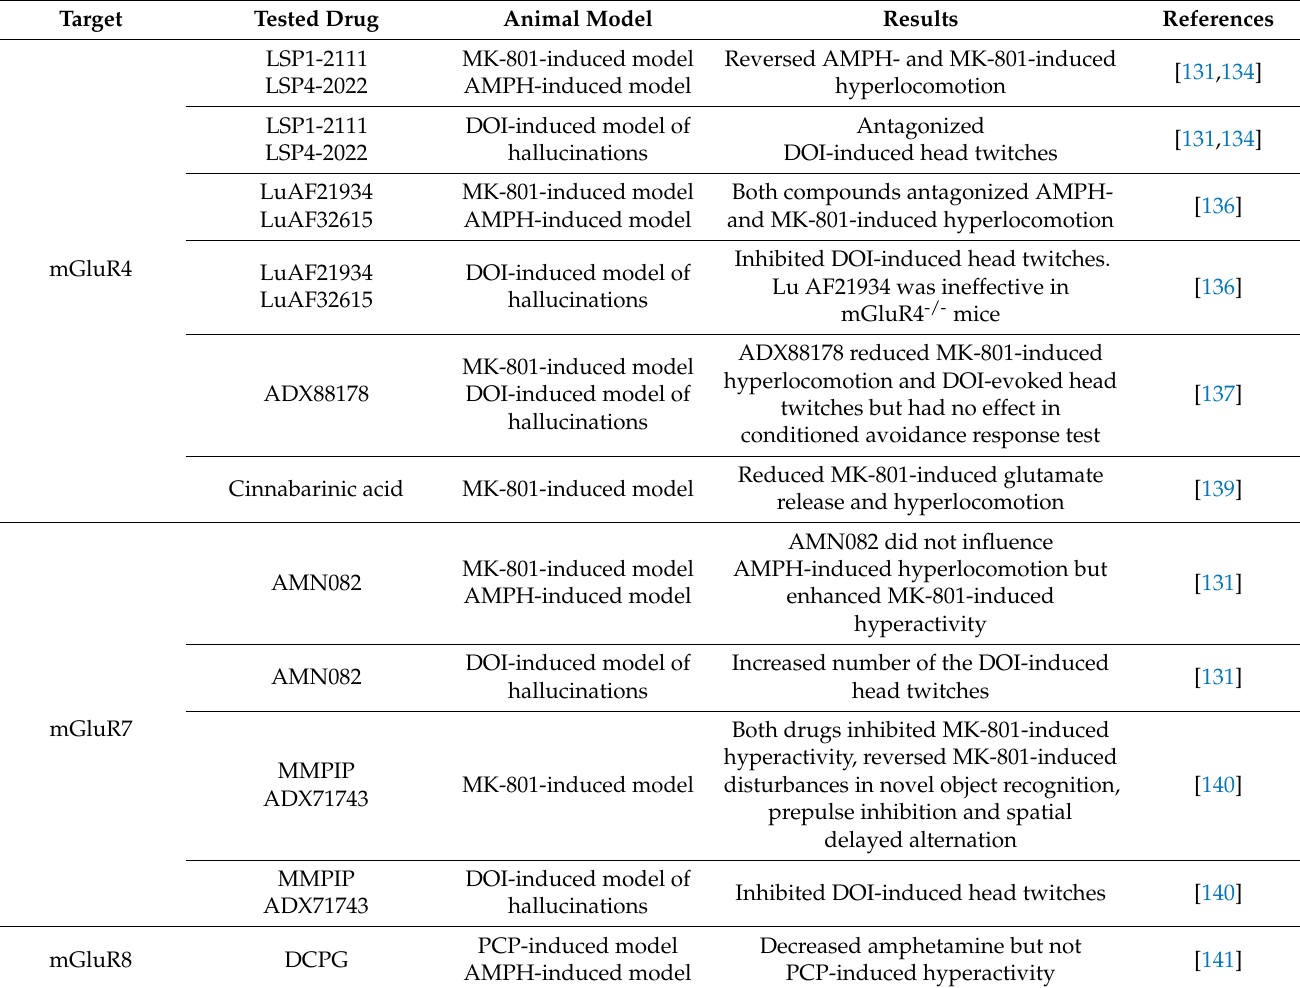
Table 4. Summary of the preclinical studies on Group III receptor